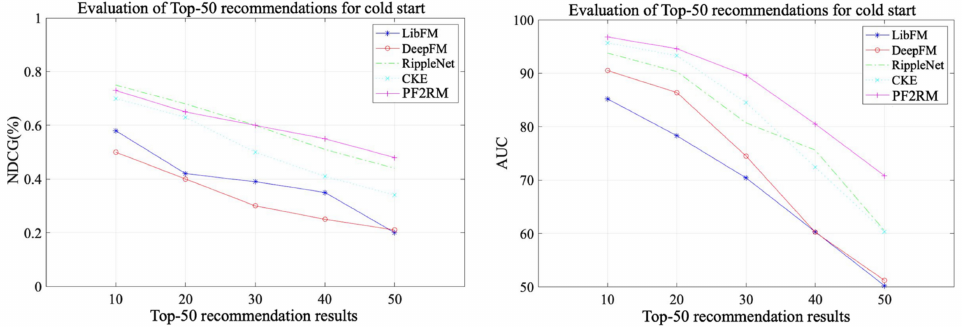
Figure 7. The evaluation charts of Top-50 recommendation results for cold-start.